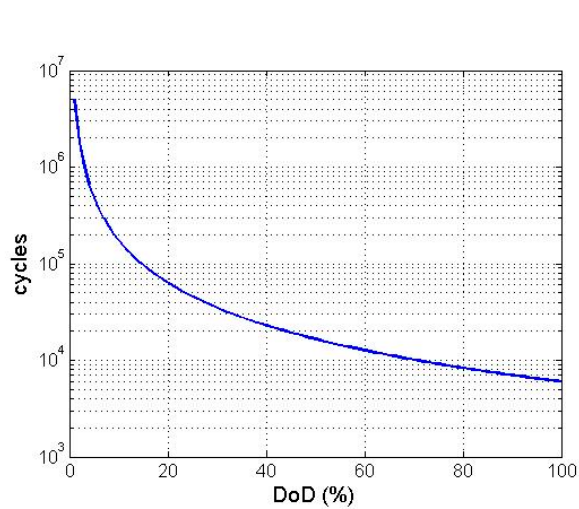
Figure 3. The cycle life versus depth of discharge (DoD; %) curve of the utilized LiFePO 4 battery (adapted from [26]). Table 1. The related parameters of the utilized battery storage system (BSS). (parameters below are